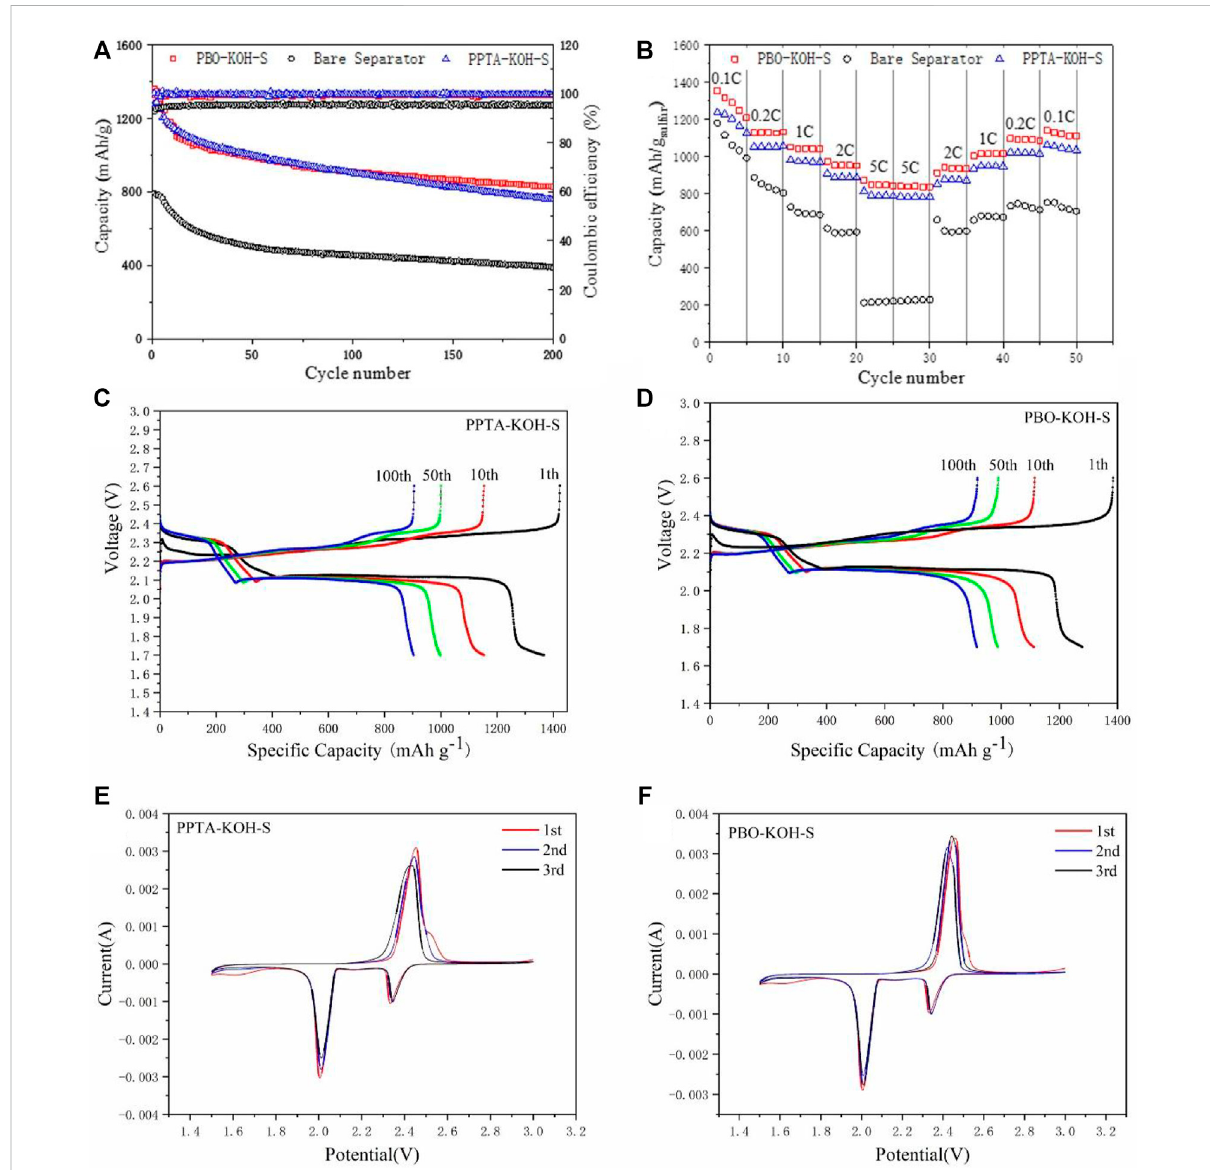
FIGURE 4 (A) Charging and discharging curves of PPTA-KOH-S and PBO-KOH-S Li-S batteries at 0.2 C by 200-cycle test; (B) Rate performance of Li-S batteries with PPTA-KOH-S and PBO-KOH-S at 0.1, 0.2, 0.5, 1, 2 and 5 C; The charging and discharging curve for 1st, 10th, 50th, 100th of Li-S batteries with (C) PPTA-KOH-S and (D) PBO-KOH-S; The CV curve of Li-S batteries with (E) PPTA-KOH-S and (F)